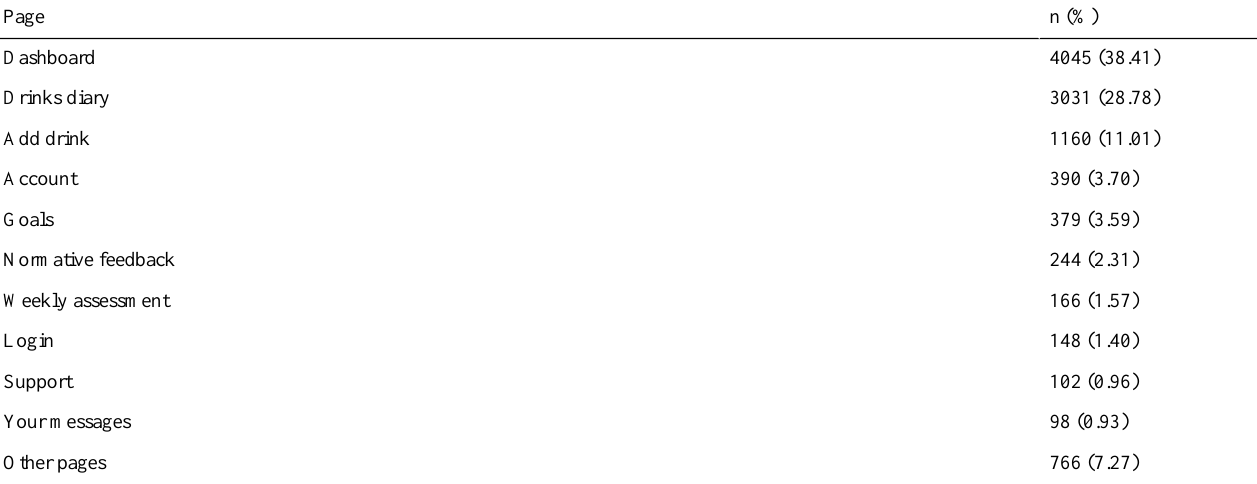
Table 3. Top 10 viewed pages within the InDEx app visited by participants within the study